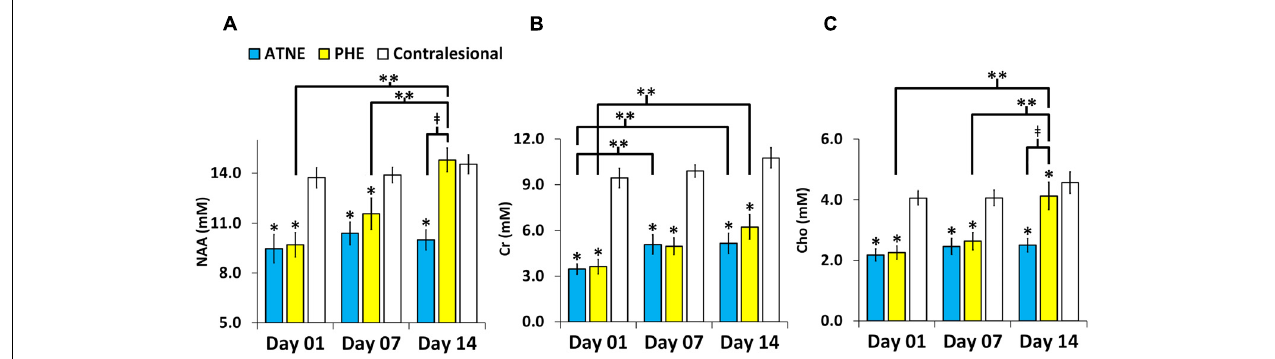
FIGURE 3 | Metabolite concentration in the perihematomal edema (PHE), adjacent tissues with no edema (ATNE), and contralesional voxels over two week follow-up post ICH. (A–C) Represent serial NAA, Cr, and Cho concentrations, respectively. The asterisk ( ∗ ) denotes significant ( p < 0.001) hemispheric differences, the double asterisk ( ∗∗ ) denotes significant ( p < 0.001) temporal difference and ( ‡ ) denotes significant ( p < 0.001) change between PHE and ATNE. The error bars represent standard error in the